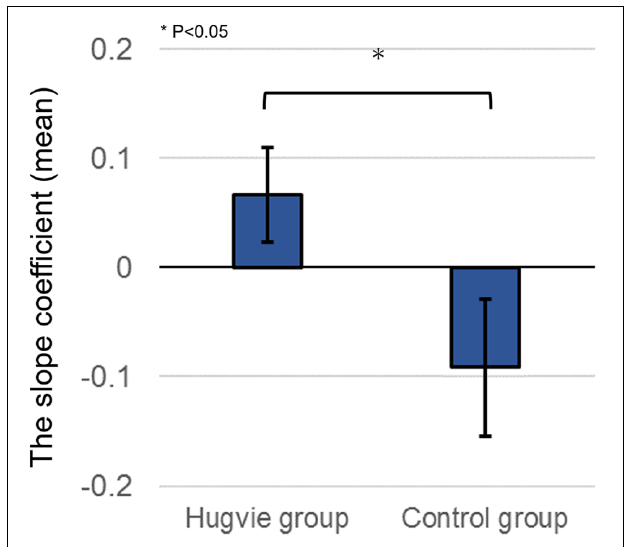
FIGURE 5 | Means of the slope coefficients in the two